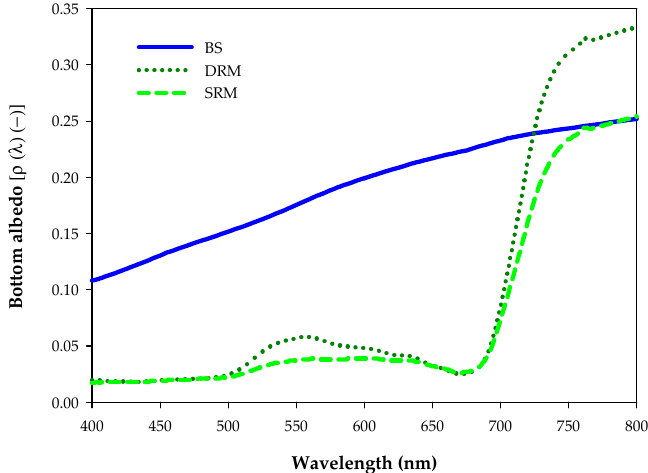
Figure 2. Albedo spectra of the three substrates sampled in the study area: BS = bare sediment; DRM = dense stands of rooted macrophytes with high albedo; and SRM = sparse stands of rooted macrophytes with low albedo.